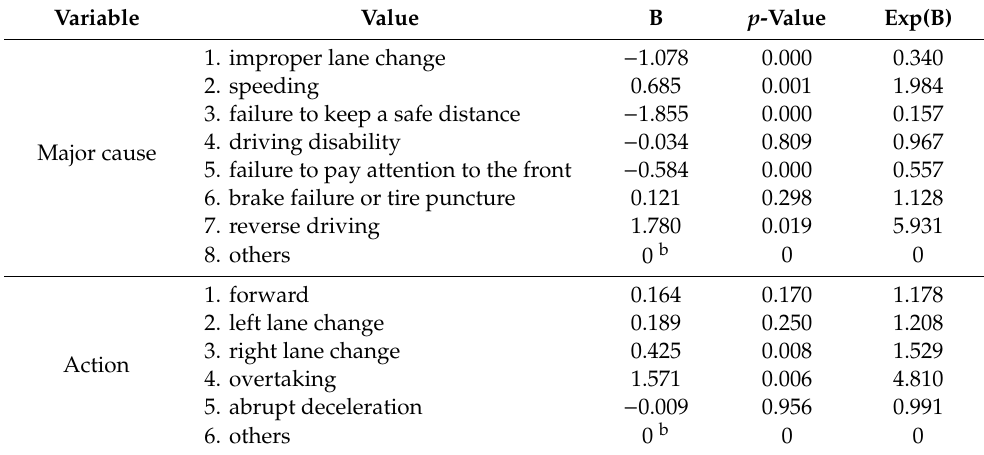
Table 8. Estimation result of variable “major cause” and “action”.